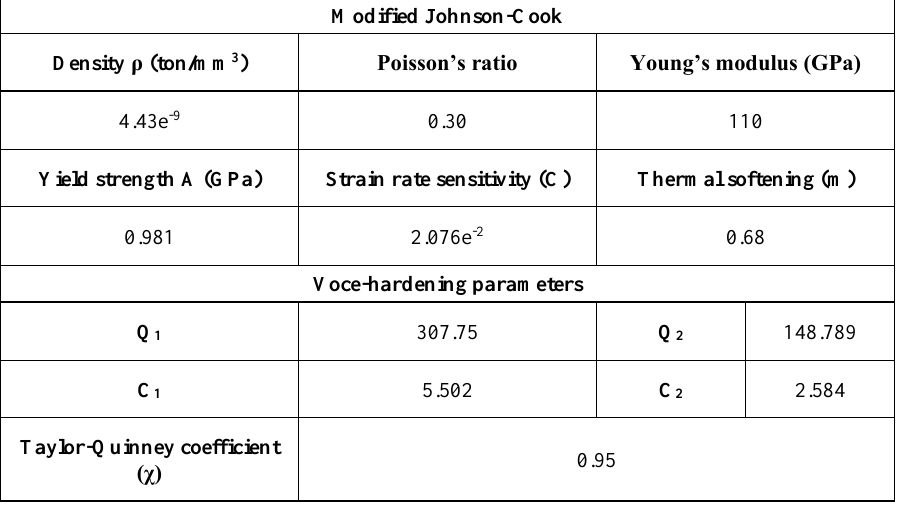
Table 1: Modified Johnson-Cook